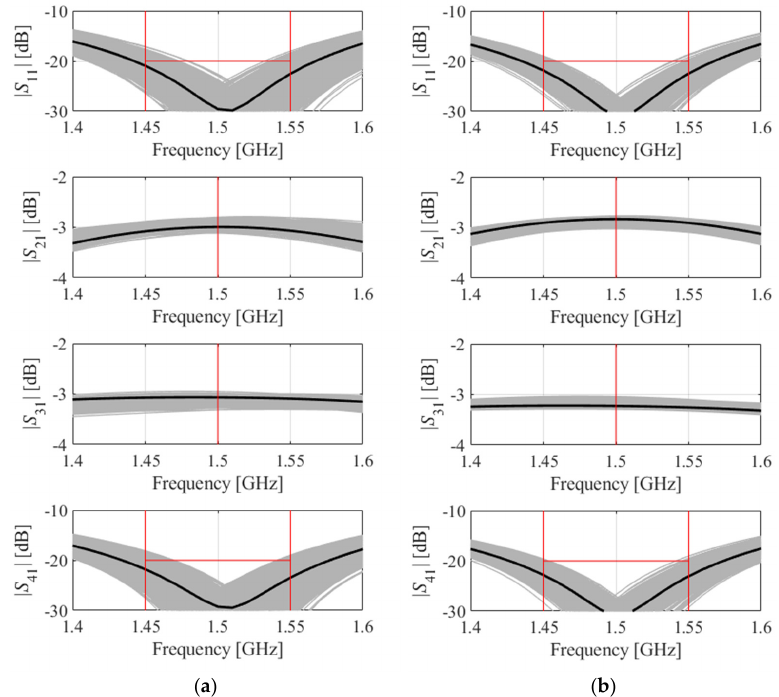
Figure 6. EM-driven Monte Carlo simulation of Circuit II (Figure 3b) at ( a ) the nominal design, and ( b ) the final design obtained using the proposed algorithm. MC carried out using 500 random samples. EM simulation data shown as gray curves. Black plots show the circuit responses at the nominal ( a ) and the optimized design ( b ).